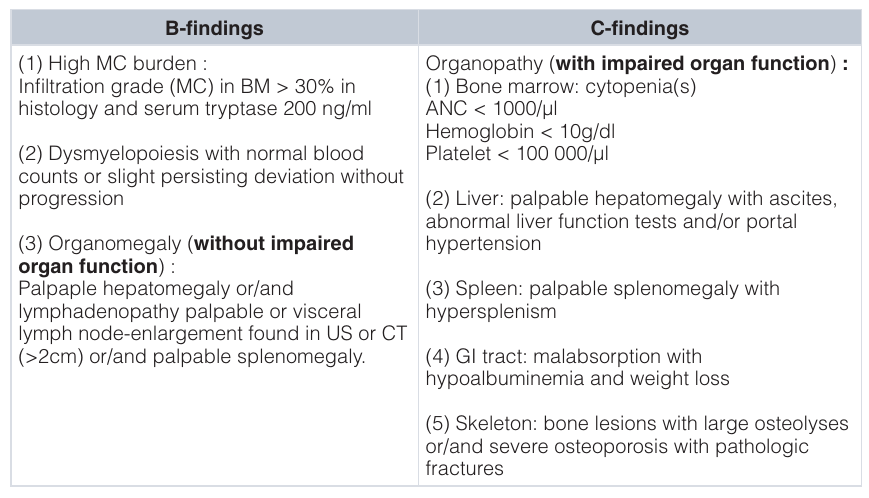
Table 2. B and C findings for the diagnosis of systemic